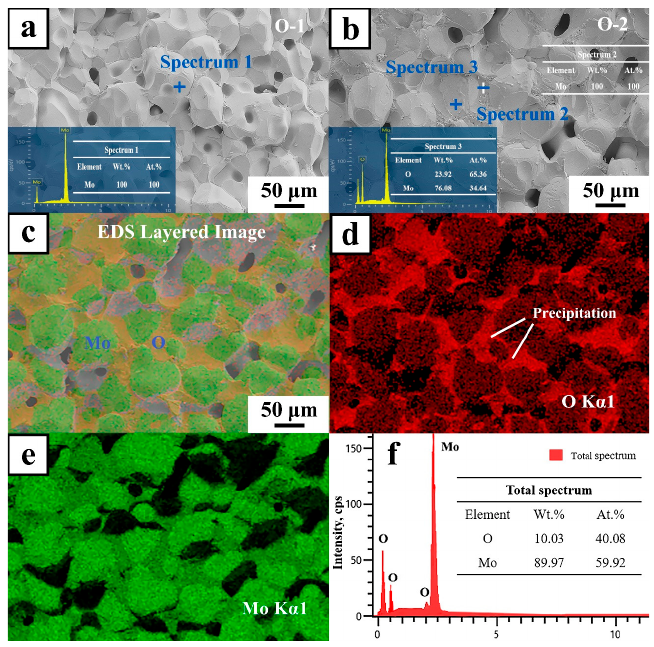
Figure 7. SEM images and EDS spectra of O-1 and O-2 samples during preparation: ( a ) O-1; ( b ) O- 2; ( c – f ) EDS mapping analysis of the O-2 sample.